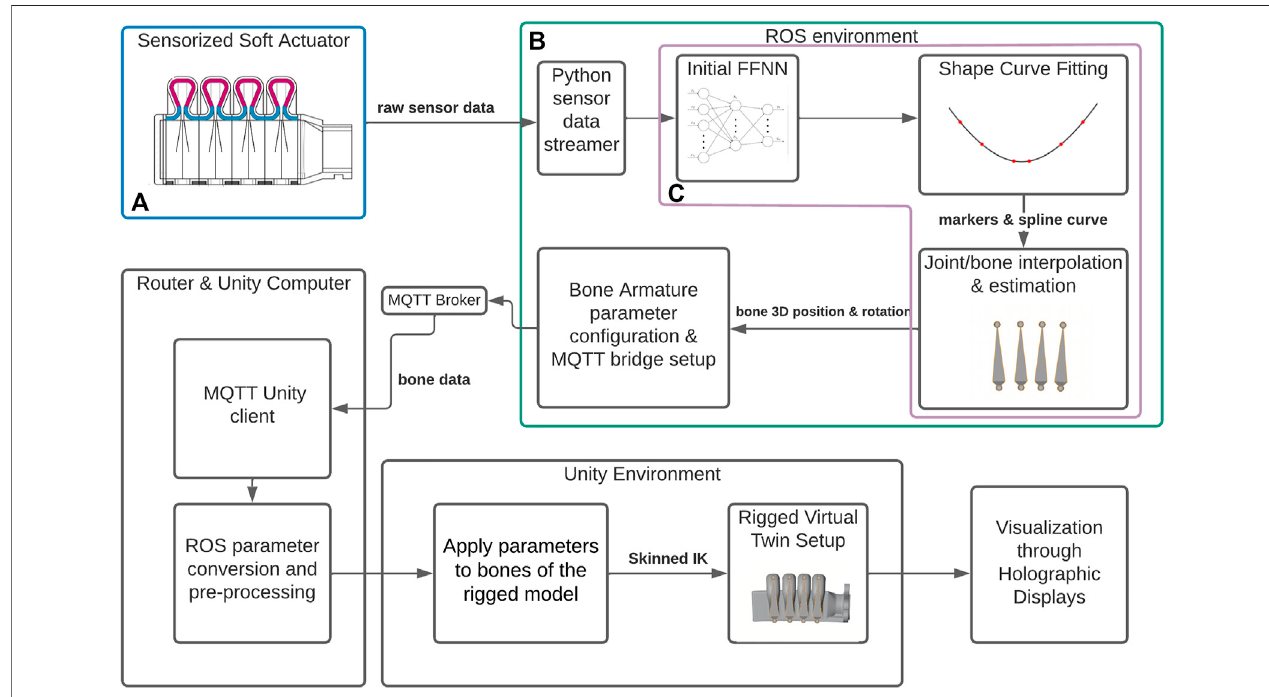
FIGURE 2 | Schematic overview of the system framework that converts the measurements from a sensorized soft actuator (A) to a real-time 3D visualization through holographic displays. (B) denotes the ROS environment and the software nodes within, while (C) indicates the Real-time processing nodes of the framework.